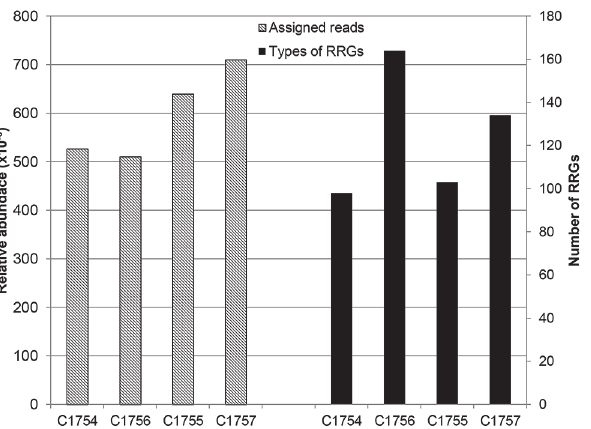
Fig 2. Abundance and diversity of annotated reads. Abundance (left) and diversity (right) of reads annotated against CARD are depicted. The hits were normalized against the total number of reads in each sample after